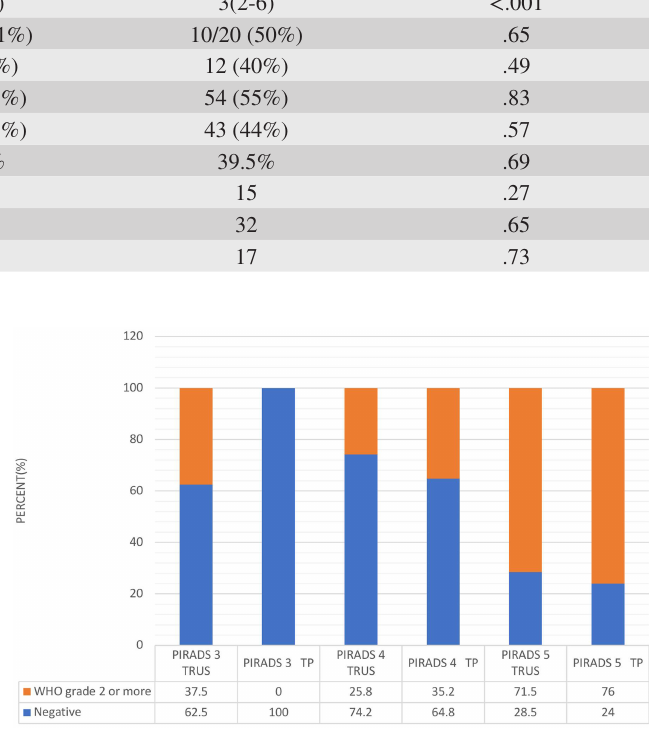
Figure 3. Detection rate of Cancer by Gleason score of Transperineal biopsy versus Transrectal biopsy of prostate. Distribution of Gleason score by PIRADS 3, 4, and 5. TRUS,